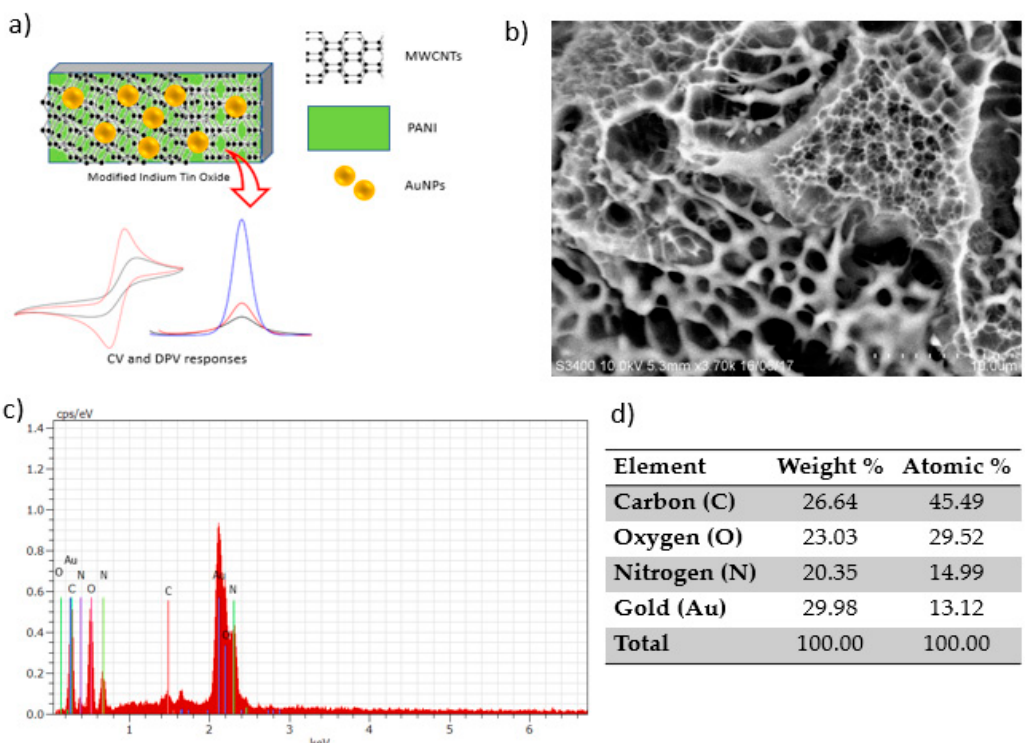
Figure 2. Polyaniline/multiwalled carbon nanotube/gold nanoparticle (PANI/MWCNT/AuNP)- modified indium tin oxide (ITO) electrode: ( a ) Schematic representation, ( b ) SEM image, ( c ) energy- dispersive X-ray (EDX) spectra and ( d ) the corresponding elemental composition.